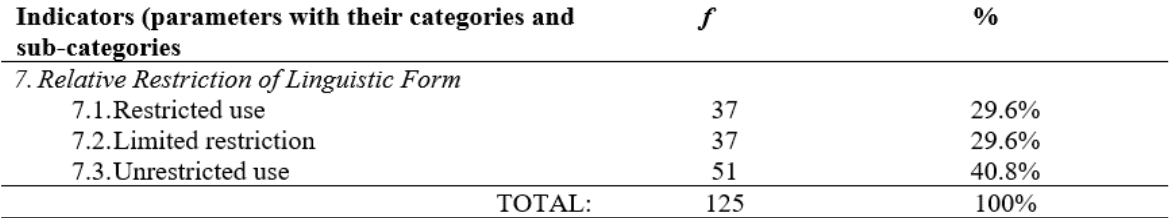
Table 8. Relative Restriction of Linguistic Form as a Communicative